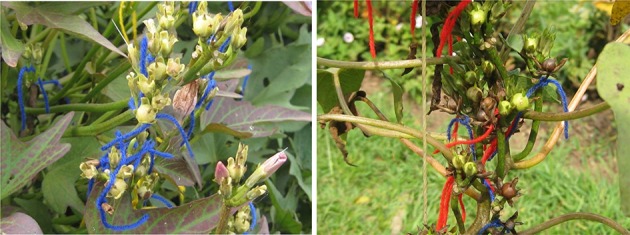
Immature capsules (left) and mature capsules (right) of sweetpotato resulted from hand crosses.